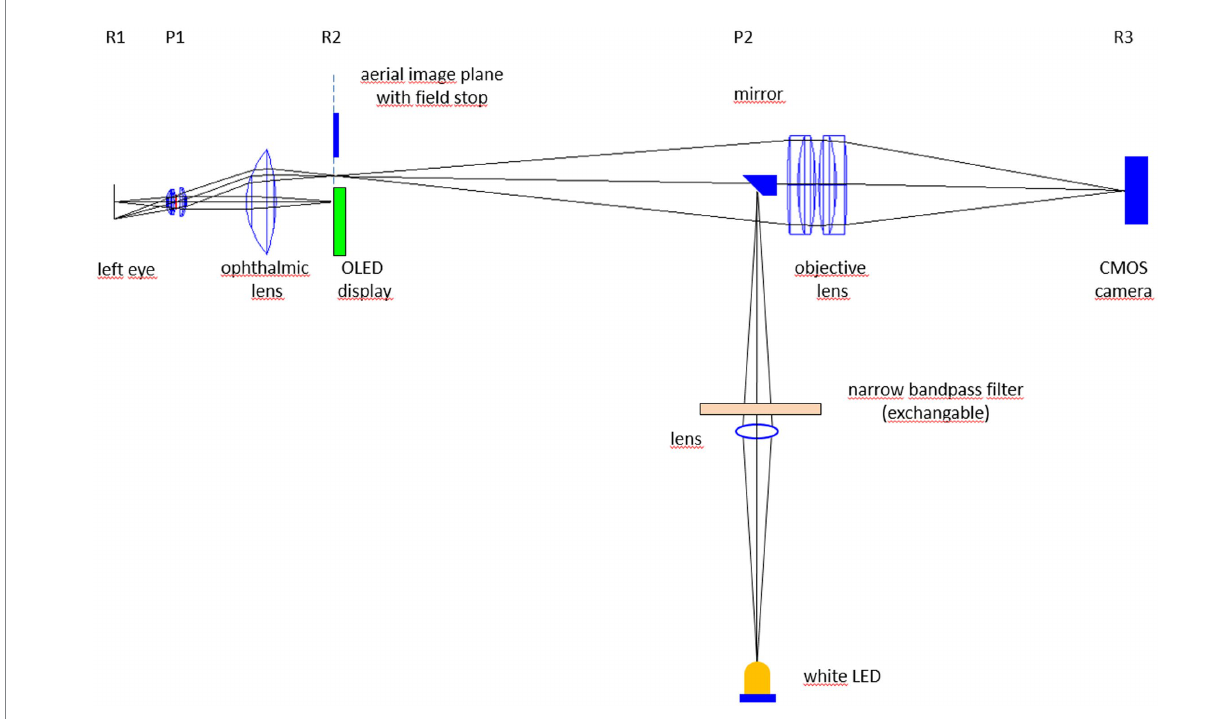
FIGURE 1 Experimental set-up of the multi-color video-ophthalmoscope. Rx and Px represent retinal (R) and pupil planes